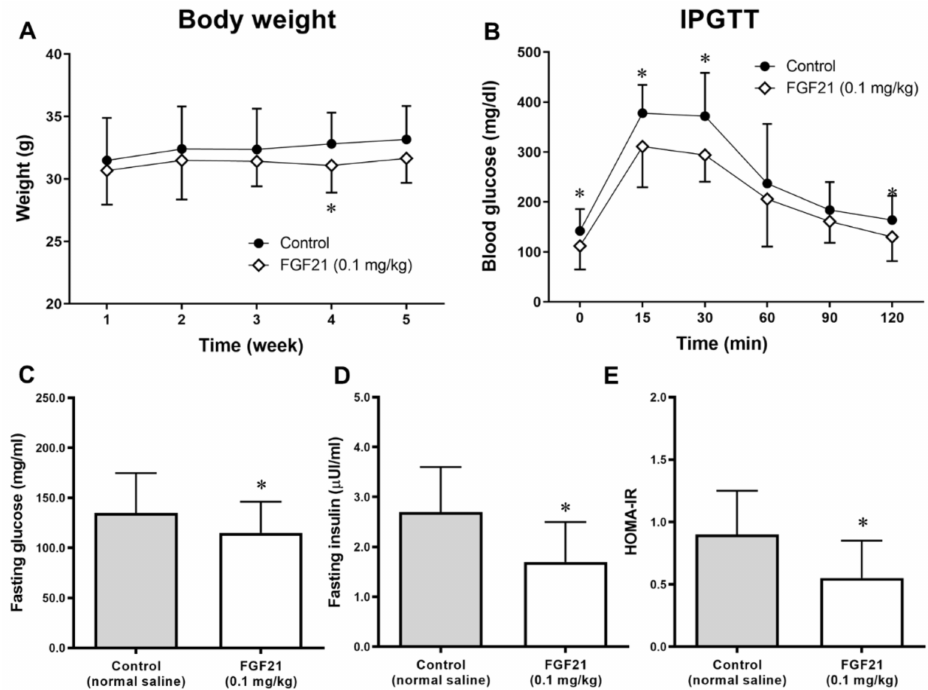
Figure 1. ( A ) Weight changes during the 5 weeks of treatment. ( B ) Glucose levels measured at 0–120 min during the intraperitoneal glucose tolerance test (IPGTT) at the end of study. ( C – E ) Fasting glucose and insulin concentrations after 5 weeks of treatment with normal saline or the fibroblast growth factor 21 (FGF21) analogue LY2405319. ( E ) Homeostasis model assessment of insulin resistance (HOMA-IR) calculated from fasting glucose and insulin levels. Data are means ± standard deviation (SD). * p < 0.05 vs.